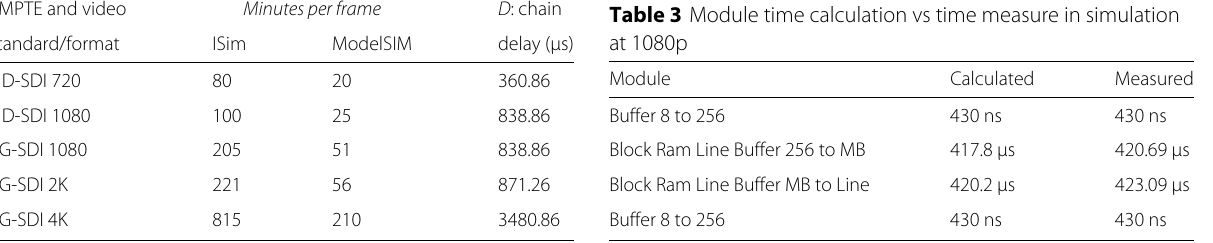
The signals y_video256 and c_video256 in the box B1 of the Fig 9 represent the input of module Block RAM Line Buffer MB to Line , while the signals y_out8 and c_out8 in the box B2, represent the output of the module Buffer 256 to 8 . The capture of this simulation is taken in the instant after the previous module, in the experiment A is out-